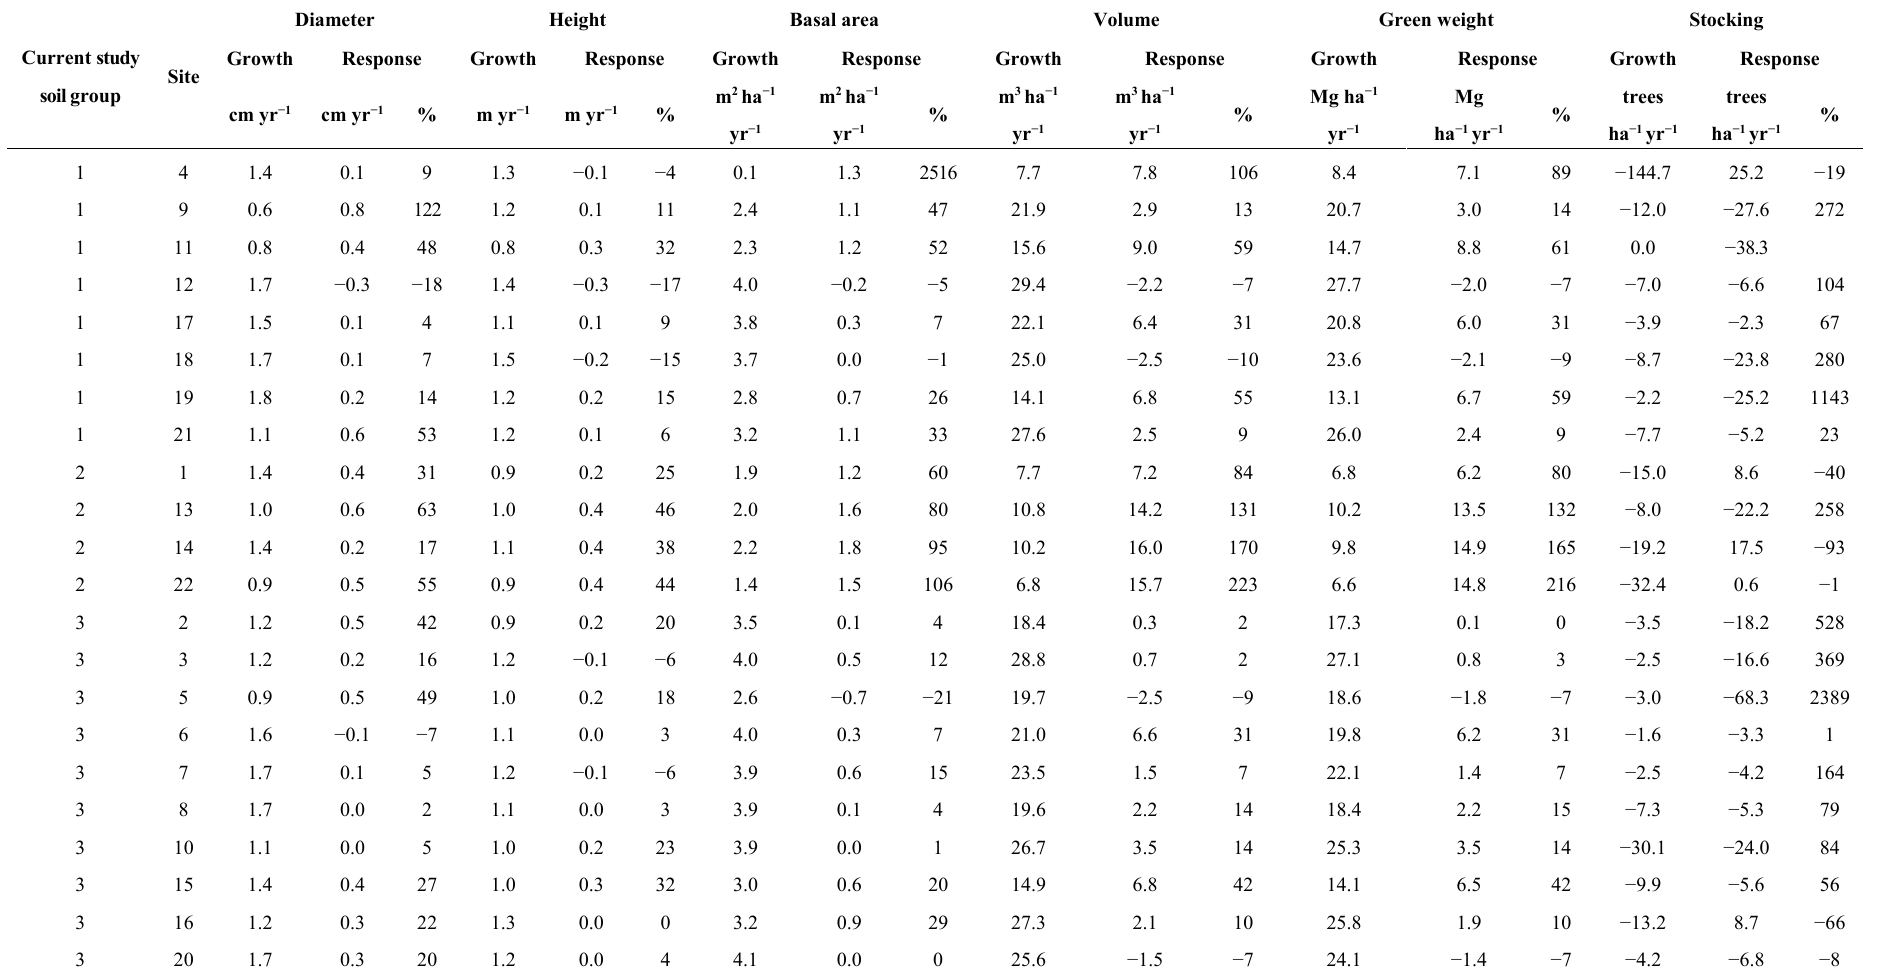
Table 6. Control treatment diameter at breast height (diameter), height, basal area, volume, green weight and stocking growth (Growth), 424 treatment absolute response (Response = treated minus control), and percentage response (%) eight years after treatment initiation for 22 sites in the southeast United States. The control treatment received no fertilization during this time and the 424 treatment received two applications of 269 kg nitrogen ha −1 and 27 kg phosphorus ha −1